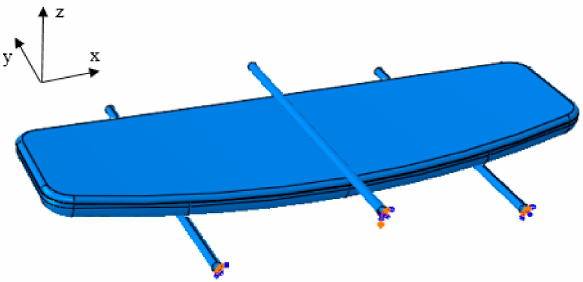
Figure 10. Boundary conditions of the finite element method model.